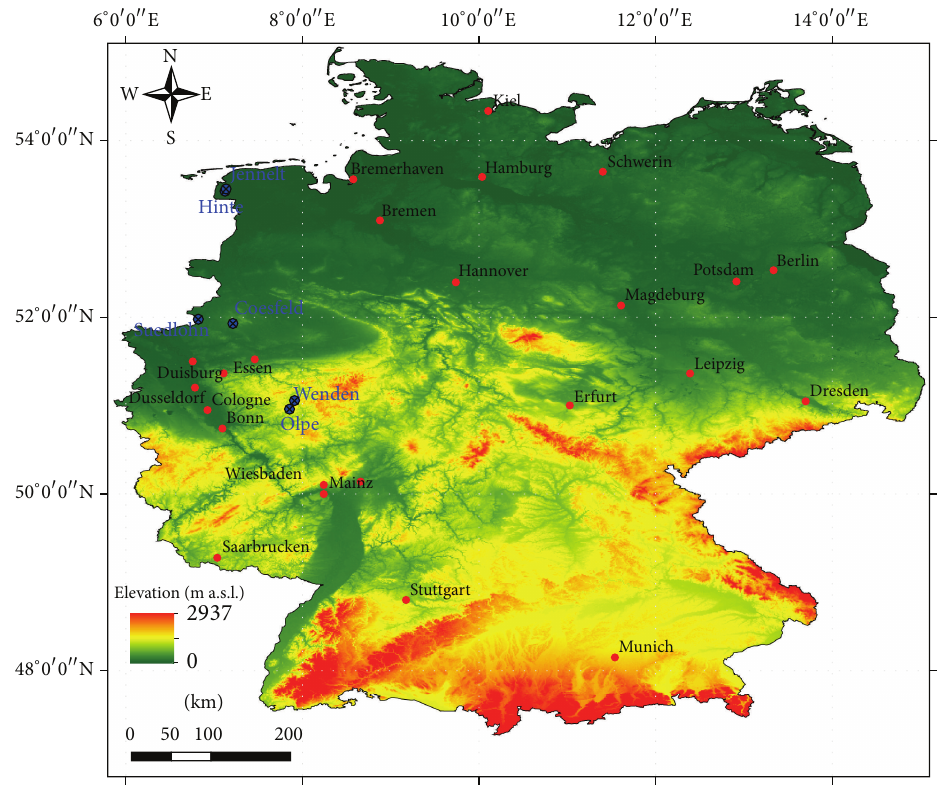
Figure 1: Shaded relief overview map of the incorporated wind farm sites in Germany. The elevations shown are based on the NASA Shuttle Radar Topography Mission data.